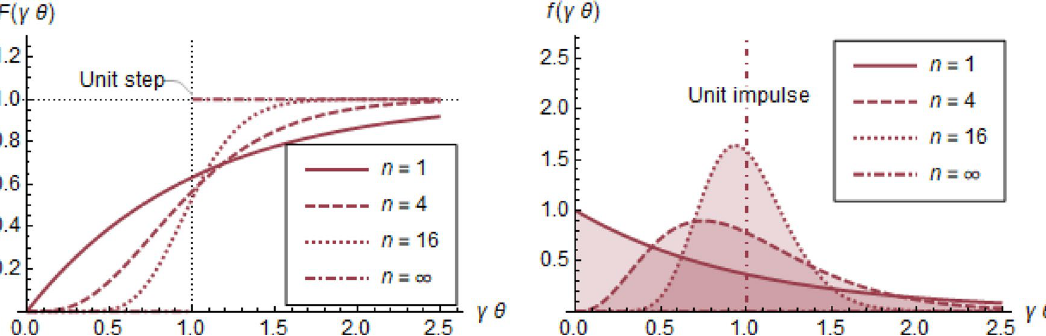
Figure 3. Sample cumulative distribution functions F (γθ) (left) and corresponding probability distribution F ′ (γθ) (right) for discharge time, T , from the I compartment of a population. Curves follow functions f (γθ) = Ŵ( n , n γθ) f (γθ) F ′ (γθ) , (see APPENDIX B). The exponential distribution 1 the formulas F (γθ) Ŵ( n ,0 ) and = = − e − γθ (right) corresponds to n 1 , whereas the impulse distribution 1 e − γθ (left) and f (γθ) with F (γθ) = = = − δ(γθ 1 ) (unit impulse, right) correspond to n H (γθ 1 ) (unit step, left) and f (γθ) with F (γθ) = − = − All distributions are shown in terms of the dimensionless variable γθ and have the same average equal to